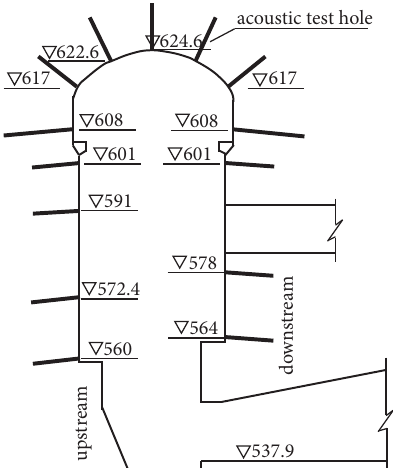
Figure 1: Typical section of acoustic